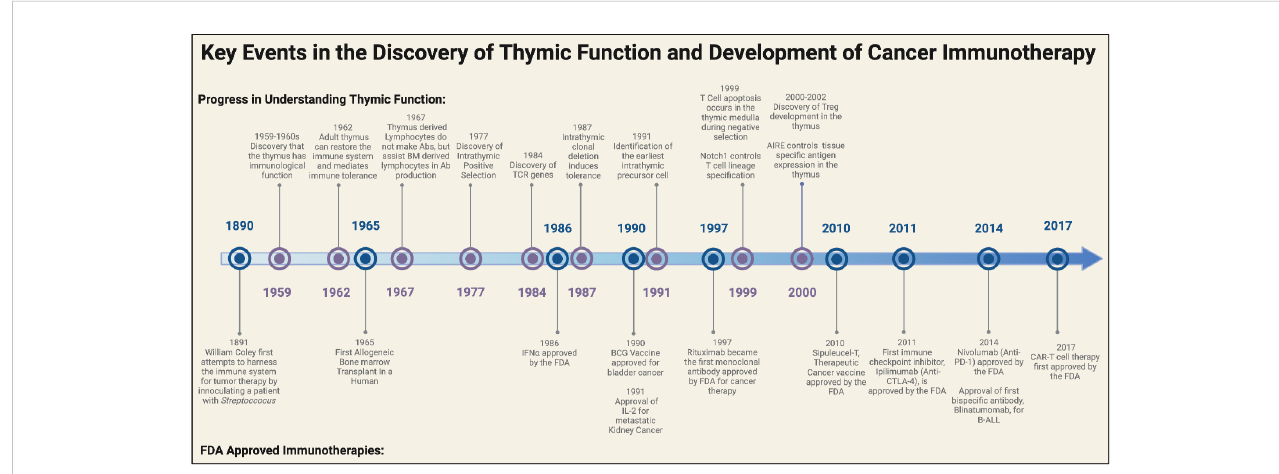
FIGURE 1 Historical timeline of major discoveries on the thymus and the development of FDA approved cancer immunotherapies. Major breakthroughs in understanding the functional role of the thymus began in the late 1950s to early 1960s. These landmark discoveries paved the way for breakthroughs in T cell biology and eventually ushered in a new era for cancer immunotherapy. Elements of this fi gure were generated using